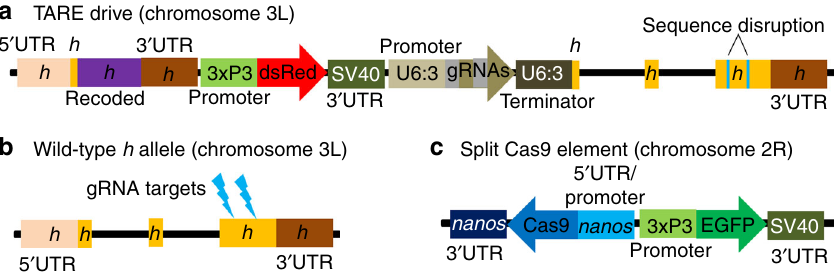
Fig. 3 Schematic of the TARE split-drive constructs. a The TARE drive is inserted into the coding region of the fi rst exon in h . The drive element contains a recoded version of h and its 3 ′ UTR, a dsRed marker gene expressed by a 3xP3 promoter together with an SV40 3 ′ UTR, and a gRNA gene consisting of two gRNAs that target h , linked by tRNAs and expressed by the U6:3 promoter. b The wild-type h allele is targeted in the coding sequencing of the third exons by the two gRNAs. c The supporting element contains Cas9 expressed by the nanos promoter with a nanos 3 ′ UTR, and an EGFP marker gene expressed by a 3xP3 promoter together with an SV40 3 ′ UTR.